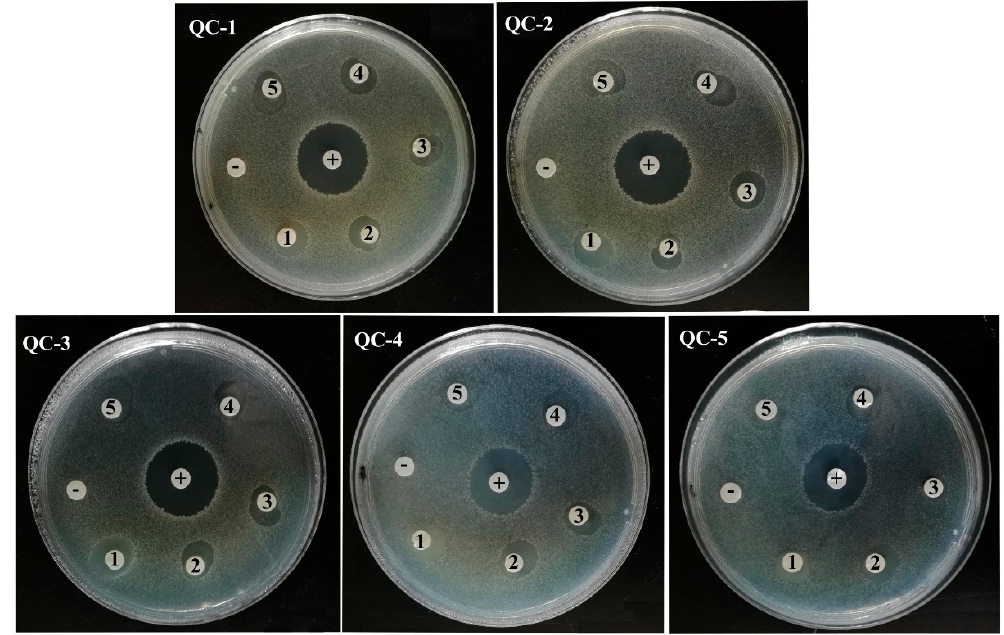
Figure 5. Antimicrobial activities against Alicyclobacillus acidoterrestris DSM 3922 T of QCs. (“+”: 100 μ g/mL Nisin in pH = 5 HCl aqueous solution, “ − ”: control group of pH = 5 HCl aqueous solution, “1”: 5 mg/mL QC solution in pH = 5 HCl aqueous solution, “2”: 2.5 mg/mL QC solution in pH = 5 HCl aqueous solution, “3”: 1.25 mg/mL QC solution in pH = 5 HCl aqueous solution, “4”: 0.625 mg/mL QC solution in pH = 5 HCl aqueous solution, “5”: 0.3125 mg/mL QC solution in pH = 5 HCl aqueous solution.